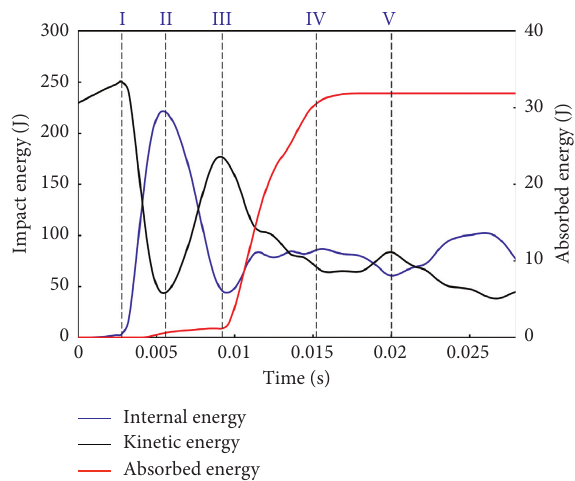
Figure 15: Conversion between the kinetic energy, internal energy, and absorbed energy for the impact energy of